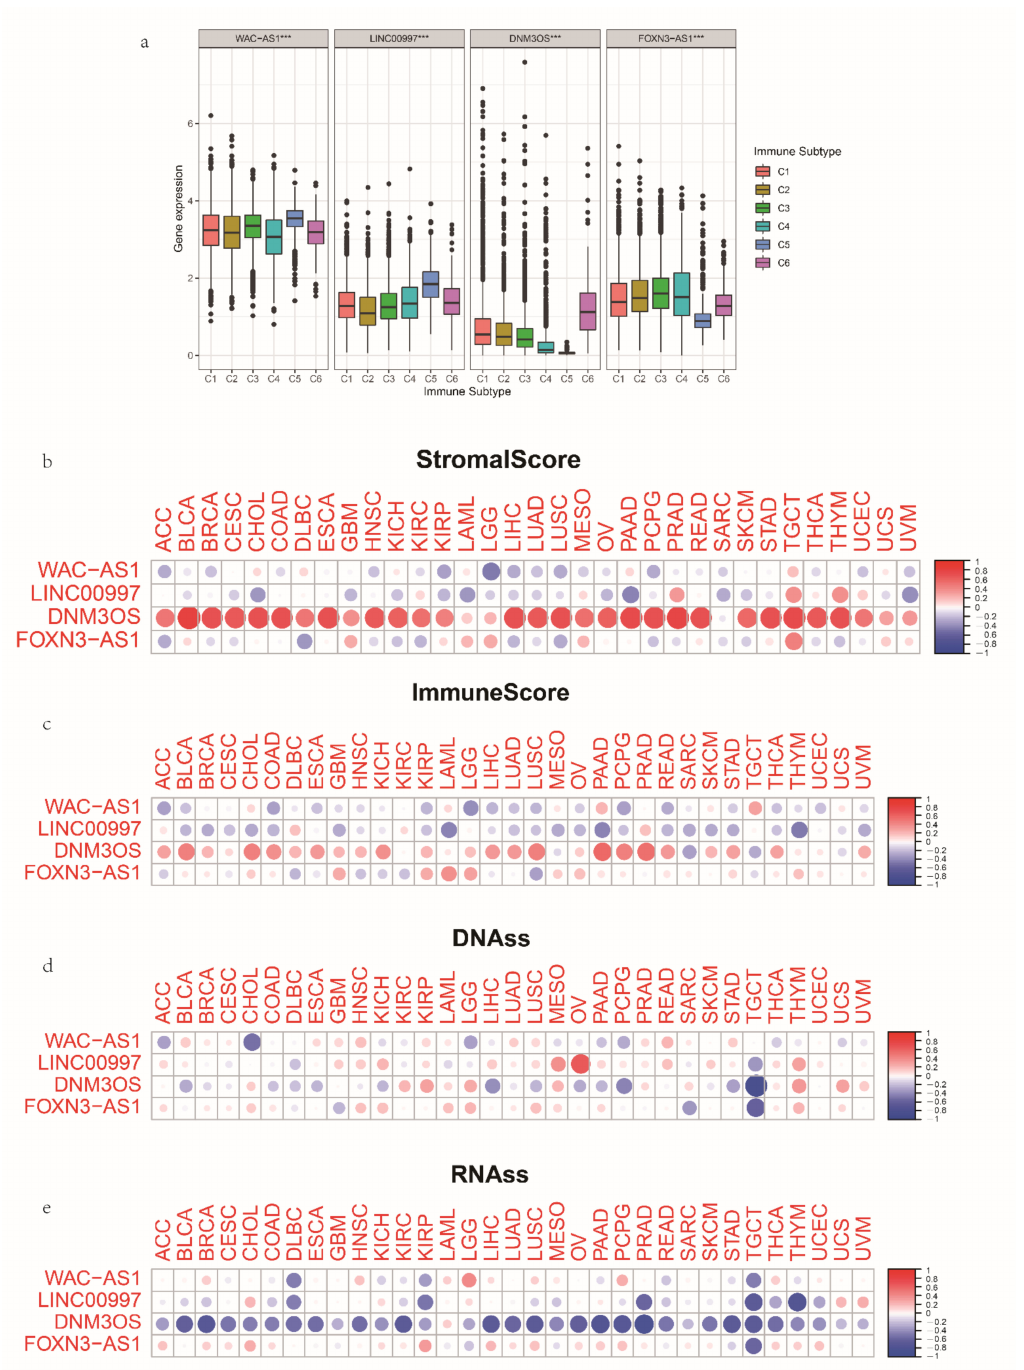
Figure 9. Association of expression of the mRLs with immune subtypes, tumor microenvironment and cancer stemness in pan-cancer. ( a ) Association of expression of the m6A-related lncRNA with immune infiltrate subtypes across all the cancer types tested with ANOVA. ( b , c ) Correlation matrix between tumor microenvironment stromal scores ( b ) and immune scores ( c ) and the mRL expression using the ESTIMATE algorithm. ( d , e ) Correlation matrix plots showing the association between the m6A-related gene expression and cancer stemness DNA score ( d ) and RNA score ( e ). *** p <